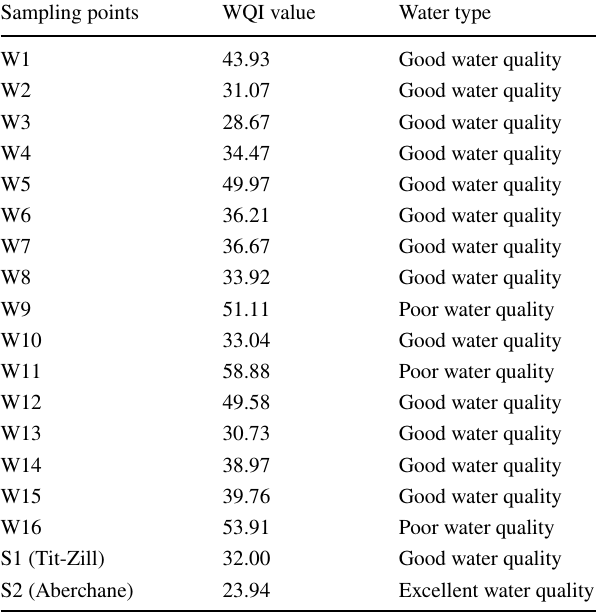
Table 4 Type of water based on the water quality index in the study area